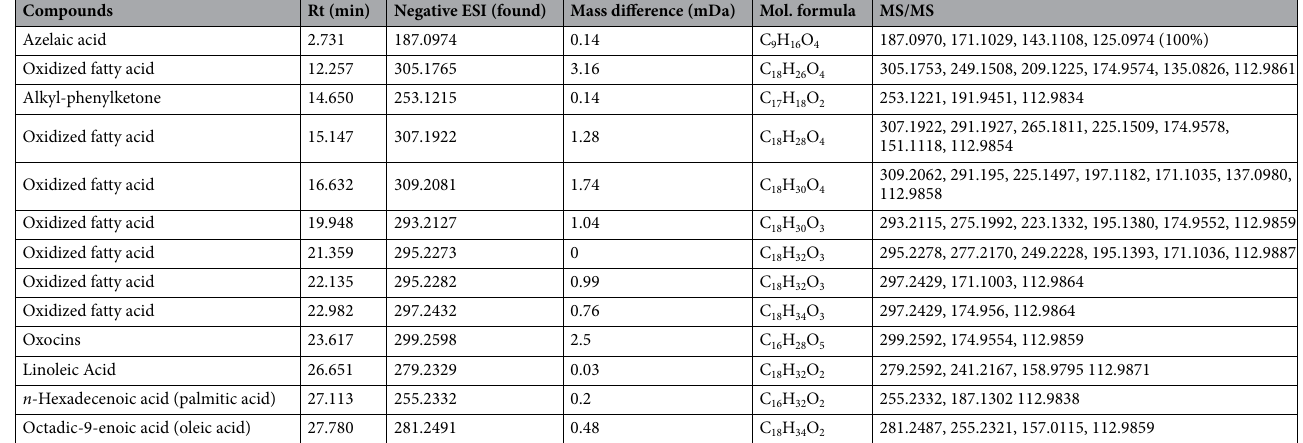
Table 8. LC-TOF–MS analysis of the DCM fraction of S. officinarum and tentative identification of